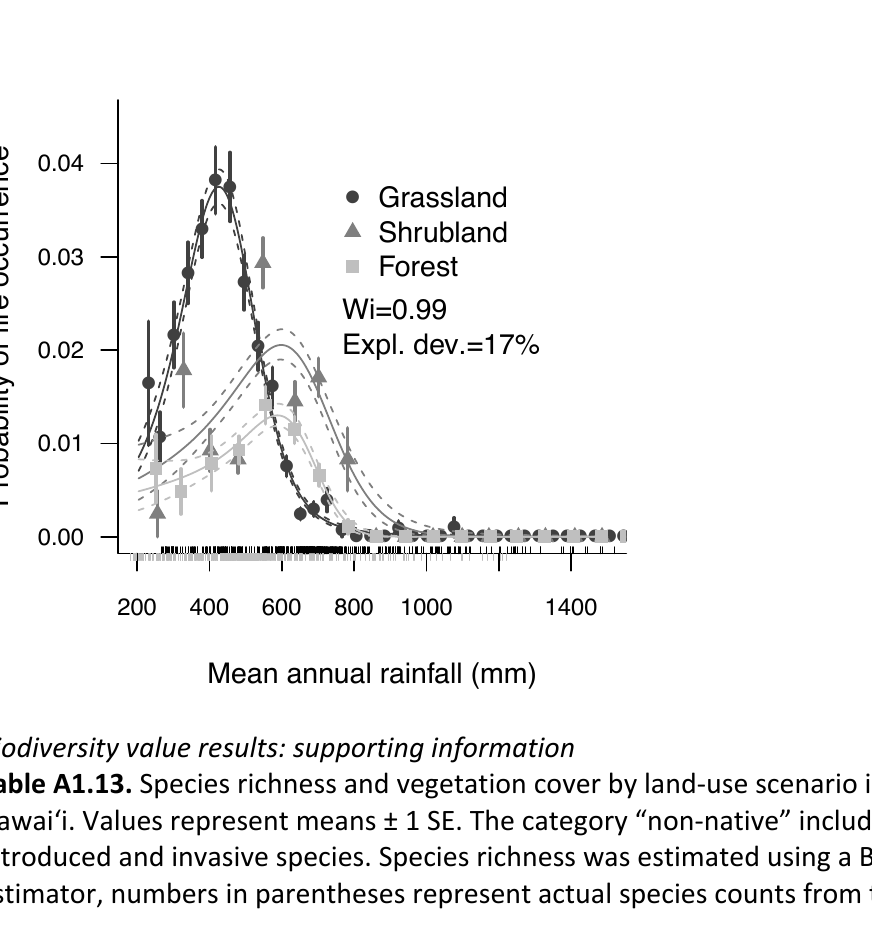
Fig A1.2 . The probability of fire occurrence for grasslands, shrublands, and forest. Points indicate actual probabilities calculated as the proportion and standard deviation (error bars) of area burned binned across the rainfall gradient. Solid lines indicate model predictions and dashed lines indicate the upper and lower 95% confidence intervals. Rug plots below illustrate the distribution of mean annual rainfall across the Kaupulehu watershed under current conditions (black rug) and under the RCP 8.5 climate change scenario (gray rug).